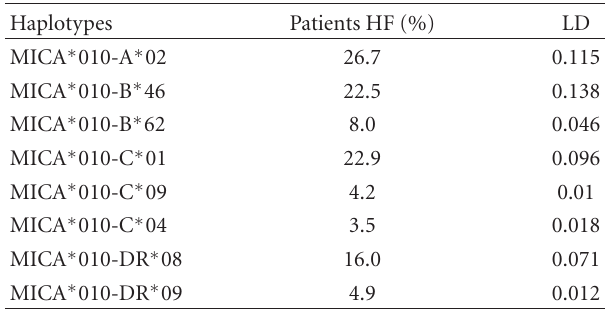
MICA: major histocompatibility complex (MHC) class I chain-related gene A;HLA:humanleukocyteantigen;AITD:autoimmunethyroiddiseases;HF: haplotype frequencies; LD: linkage